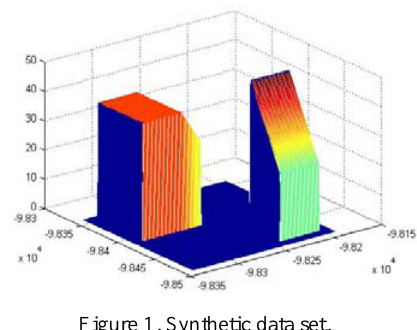
Figure 1. Synthetic data set.